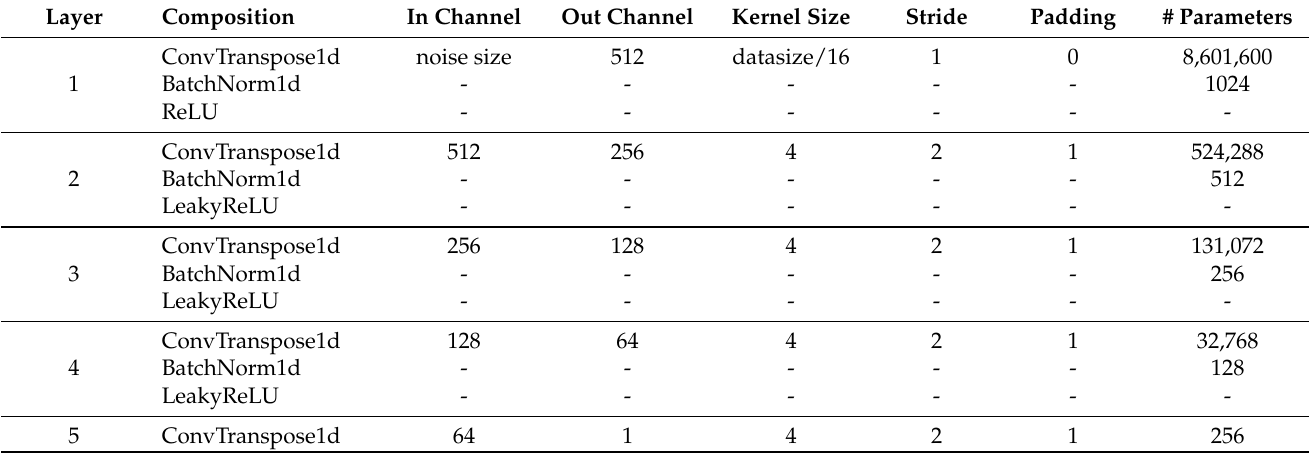
Table 2. Network layer structure of the generator in GAN used for the proposed system.